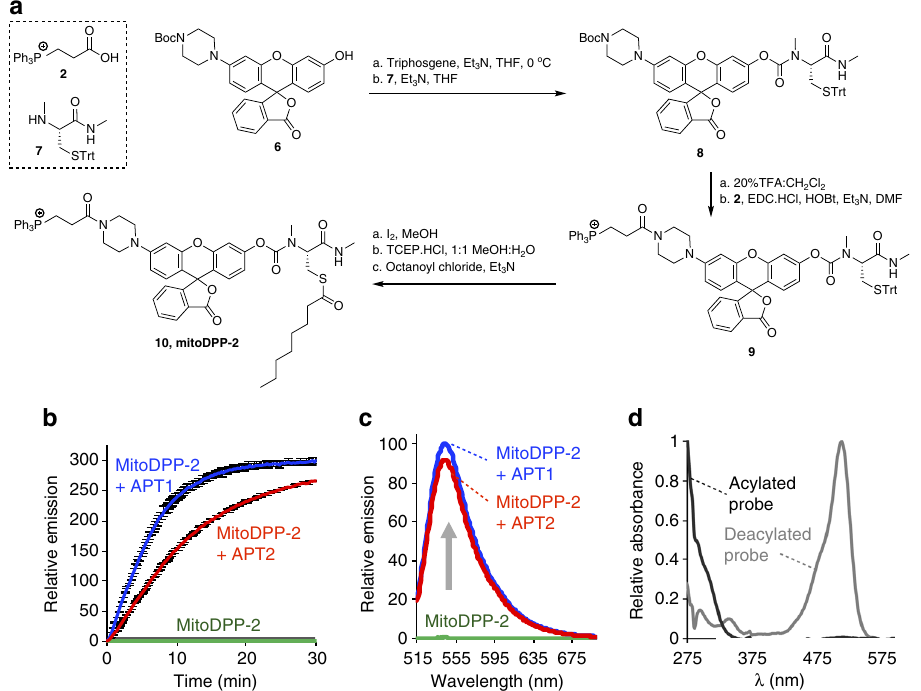
Fig. 2 Synthesis and in vitro activity of mitoDPP-2. a Synthetic scheme for mitoDPP-2. b In vitro fl uorescence assay of mitoDPP-2 (1 µ M) in HEPES (20 mM, pH 7.4, 150 mM NaCl, 0.1% Triton X-100) with either 50 nM puri fi ed APT1 or APT2 ( λ ex 490/20 nm, λ em 545/20 nm). Error bars are ± s.e.m. ( n = 3). c Fluorescence emission spectra at 30 min from probes as treated in ( b ). d UV – vis spectra of 25 µ M mitoDPP-2 (black; normalized at 275 nm) and deprotected fl uorophore product (gray; normalized at 513 nm) in HEPES (20 mM, pH 7.4, 150 mM NaCl, 0.1% Triton X-100). MitoDPP-2 shows UV – vis absorbance at 300 nm with extinction coef fi cient 8.7 × 10 3 M − 1 cm − 1 . The deprotected fl uorophore product shows a major UV-Vis absorbance peak at 513 nm with extinction coef fi cient 11.8 × 10 3 M − 1 cm −